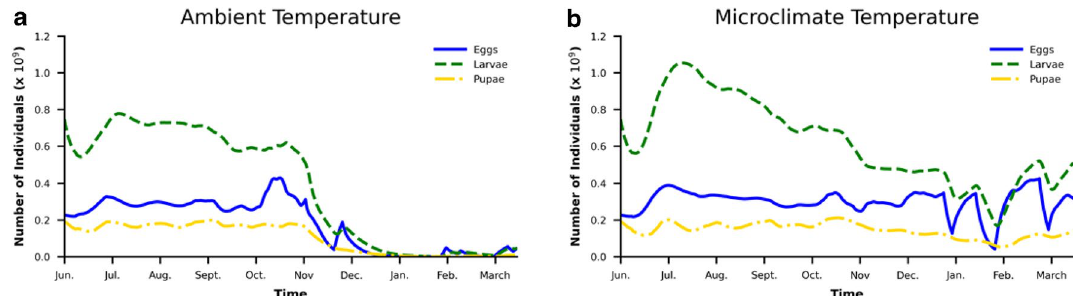
Figure 10. Eggs and Juvenile population under ( a ) ambient and ( b ) microclimatic conditions.